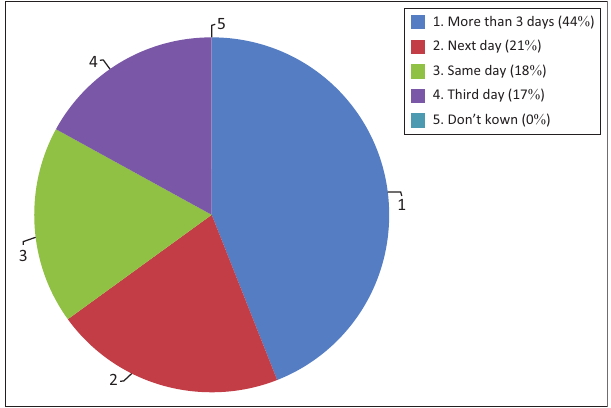
FIGURE 4: Time treatment initiated after onset of